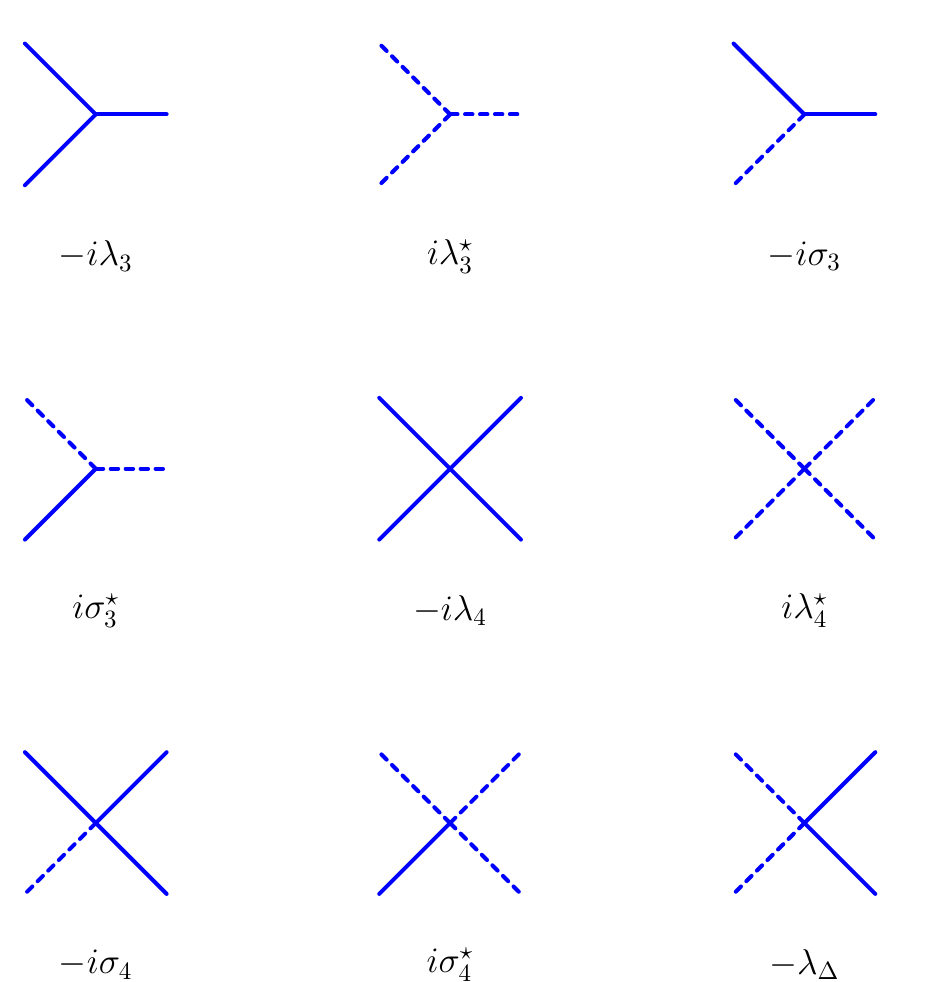
Table 2. Feynman rules for the SK theory.